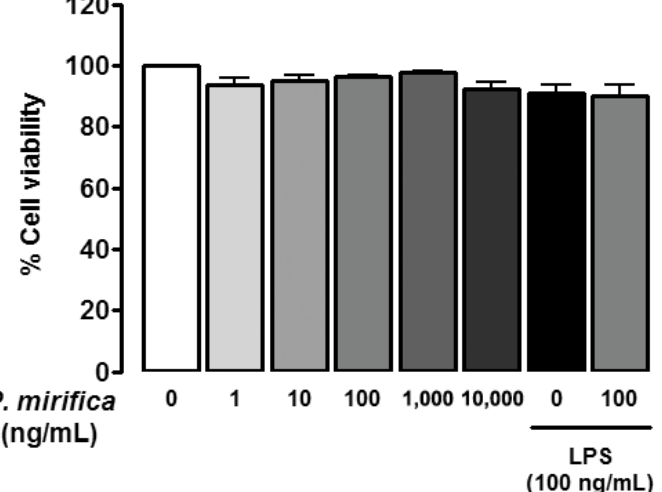
Figure 1. Effects of P. mirifica extract and LPS on microglial viability. HAPI cells (5 × 10 5 cells/well) were treated with graded concentrations of ethyl acetate extract of P. mirifica , LPS (100 ng/mL), or coincubation of P. mirifica extract with LPS (both at 100 ng/mL) for 24 h and cell viability was determined with an MTT assay. Each value is the mean percentage ± SD when compared with the vehicle-treated control (100%) from three individual experiments.